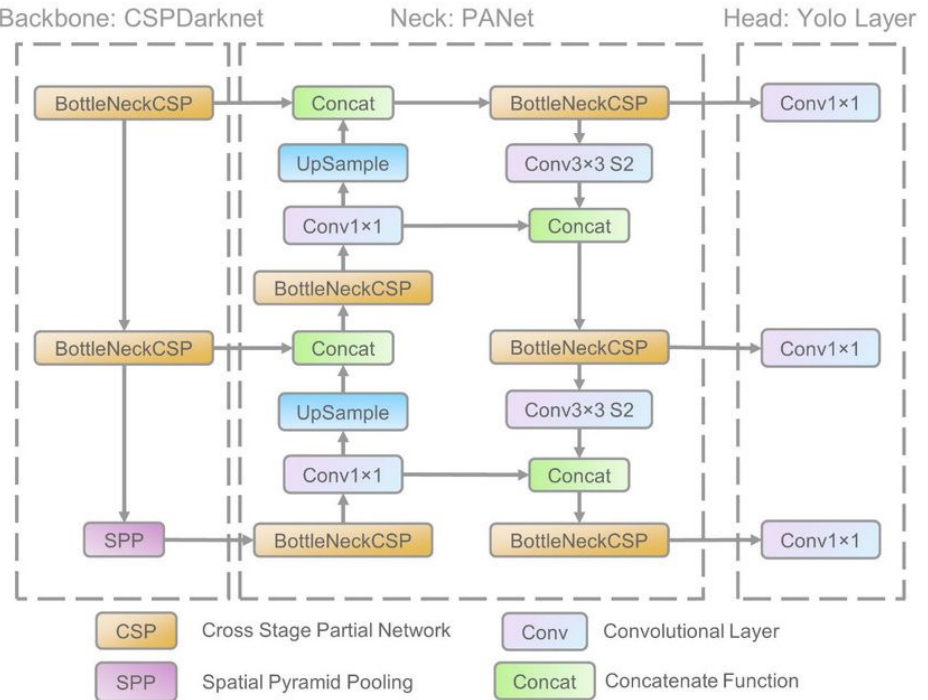
Figure 4. Architecture of